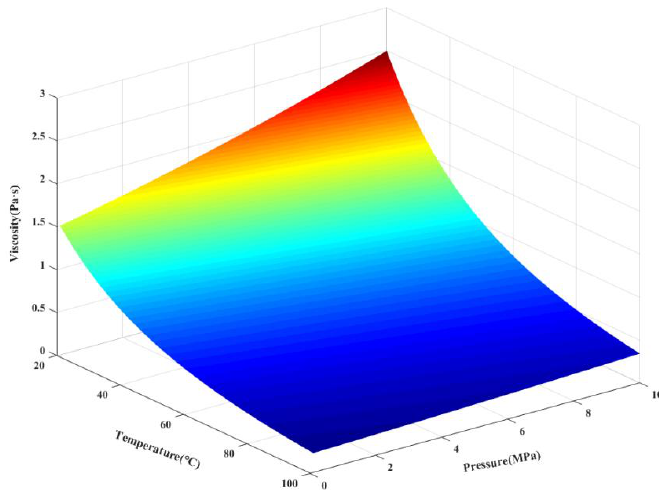
Figure 4. Magnetic fluid lubrication film viscosity relationship.